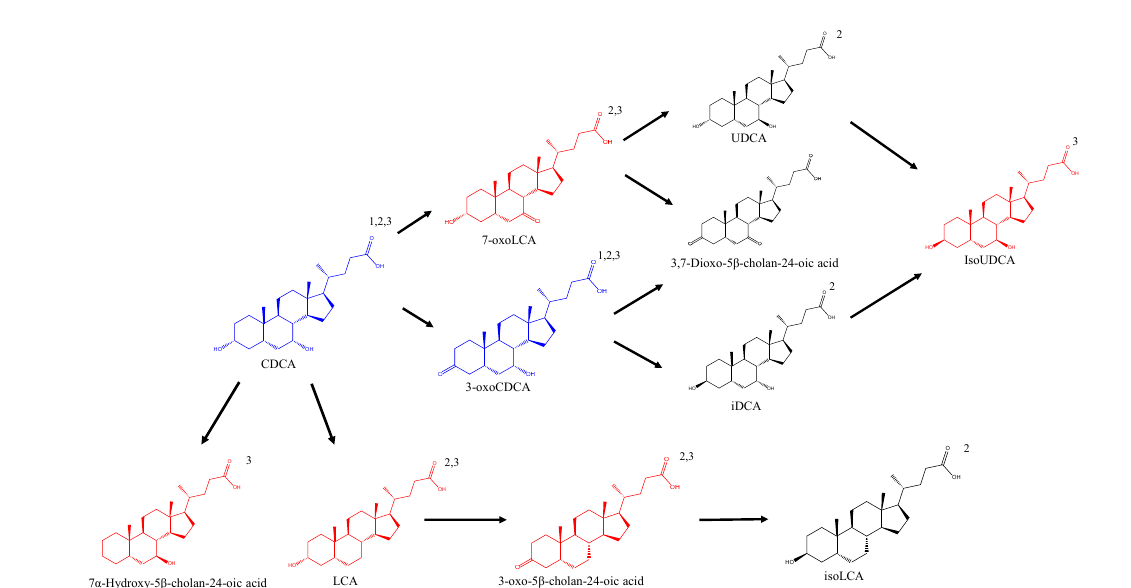
Figure 2. BAs trend identified after samples incubation. Black color: non-detected; Red color: detected after incubation; Blue color: incubated and detected. CDCA: Chenodeoxycholic acid; LCA: Lithocholic acid; UDCA: Ursodeoxycholic acid; iDCA Isodeoxycholic acid. 1: Identified with authentic standard; 2: Identified according retention time based on Reiter et al ., 2021; 3: Identified by MS/MS fragments. Table 1. BAs identified and confirmed of classical conversion trend of secondary BAs.